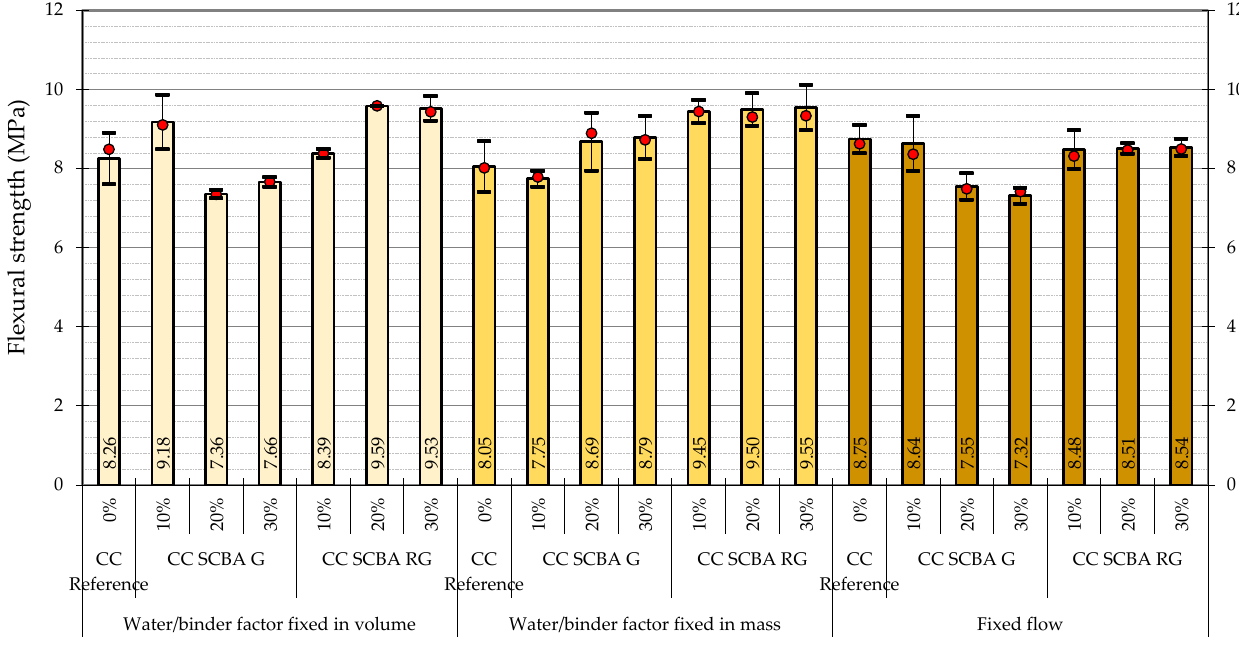
Figure 15. Flexural strength of mortars.